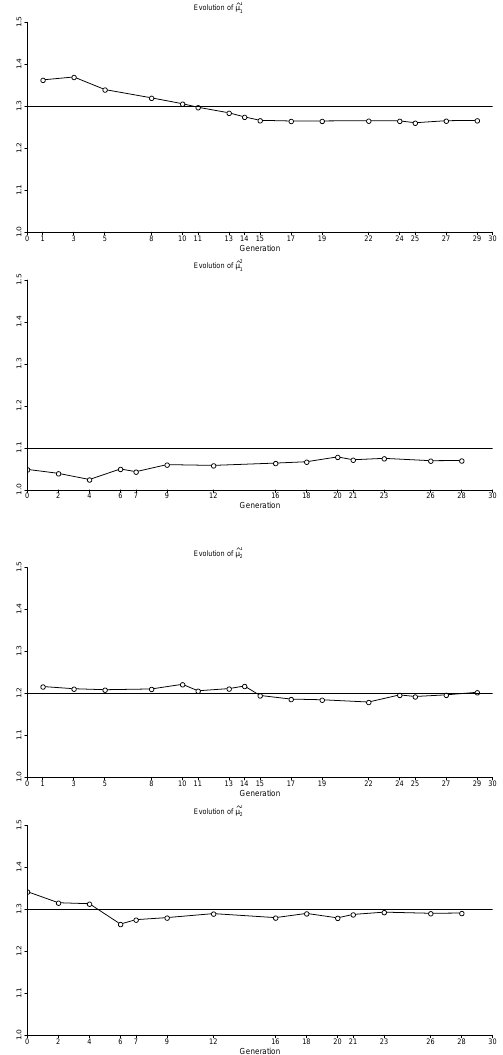
Figure 1. Evolution of the estimates (cid:99) µ 1 and T 2 ,